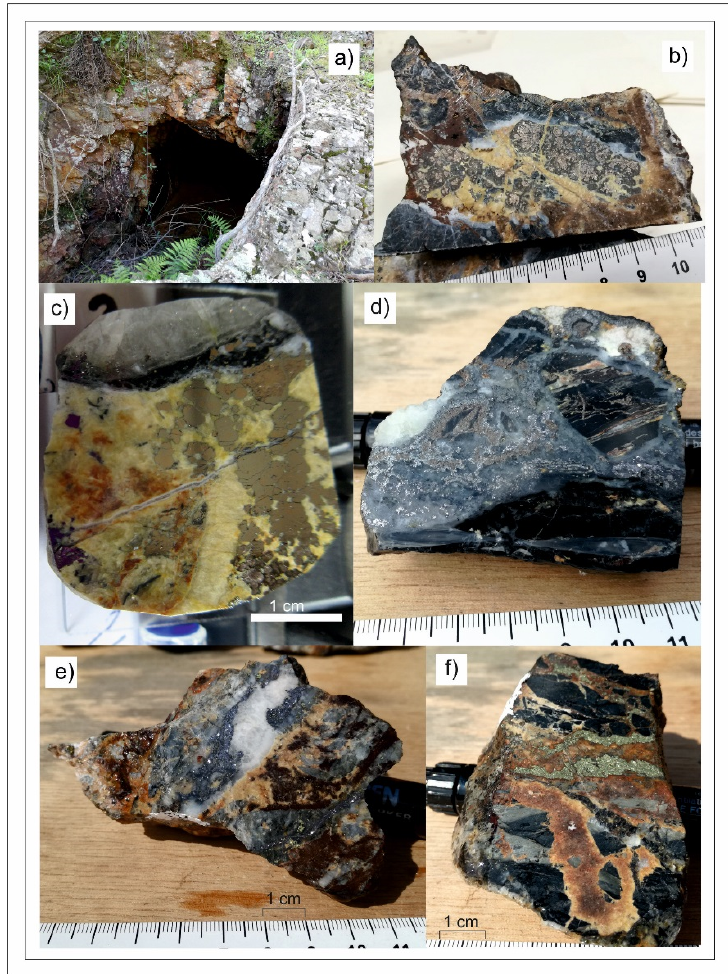
Figure 2. Outcrop and macroscopic textures of the mineralization from the SW Sardinian veins. Montevecchio mining district. ( a ) Entrance of an old adit at the Sa Menga mining site with exposed carbonate-rich mineralization (rusty patches); ( b ) cockade and brecciated ore with Ni–Co-rich aggregates, showing visible niccolite cores, overgrown by siderite and quartz and crosscut by later carbonate veinlets (Sa Menga); ( c ) Ni–Co-rich cockade nodules in siderite and crosscut by quartz veinlets, and with fragments of Silurian black shale (Acqua Is Prunas); ( d ) brecciated ore with large fragments of black shale and arborescent aggregate of Ni–Co arsenides in quartz (Pira Inferida); ( e ) galena-rich (with sphalerite and tetrahedrite) ore in quartz veinlets cementing brecciated siderite-rich patches (Sa Menga); ( f ) chalcopyrite- and, to the right, sphalerite-rich bands with quartz crosscutting brecciated black shale cemented by siderite (Sa Menga).